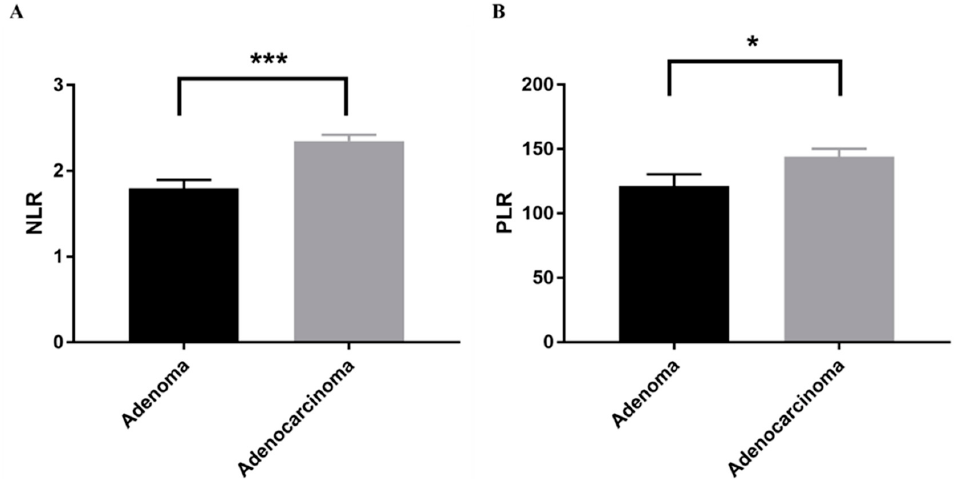
Figure 2. Comparison between adenoma and adenocarcinoma group. Quantitative analysis of ( A ) NLR and ( B ) PLR in the adenoma group and the adenocarcinoma group. Bars indicate average ± SEM. * p < 0.05 (Mann-Whitney U test); *** p < 0.001 (Student’s t -test). NLR, neutrophil-to-lymphocyte ratio; PLR, platelet-to-lymphocyte ratio. Table 2. Characteristics in patients with adenocarcinoma.